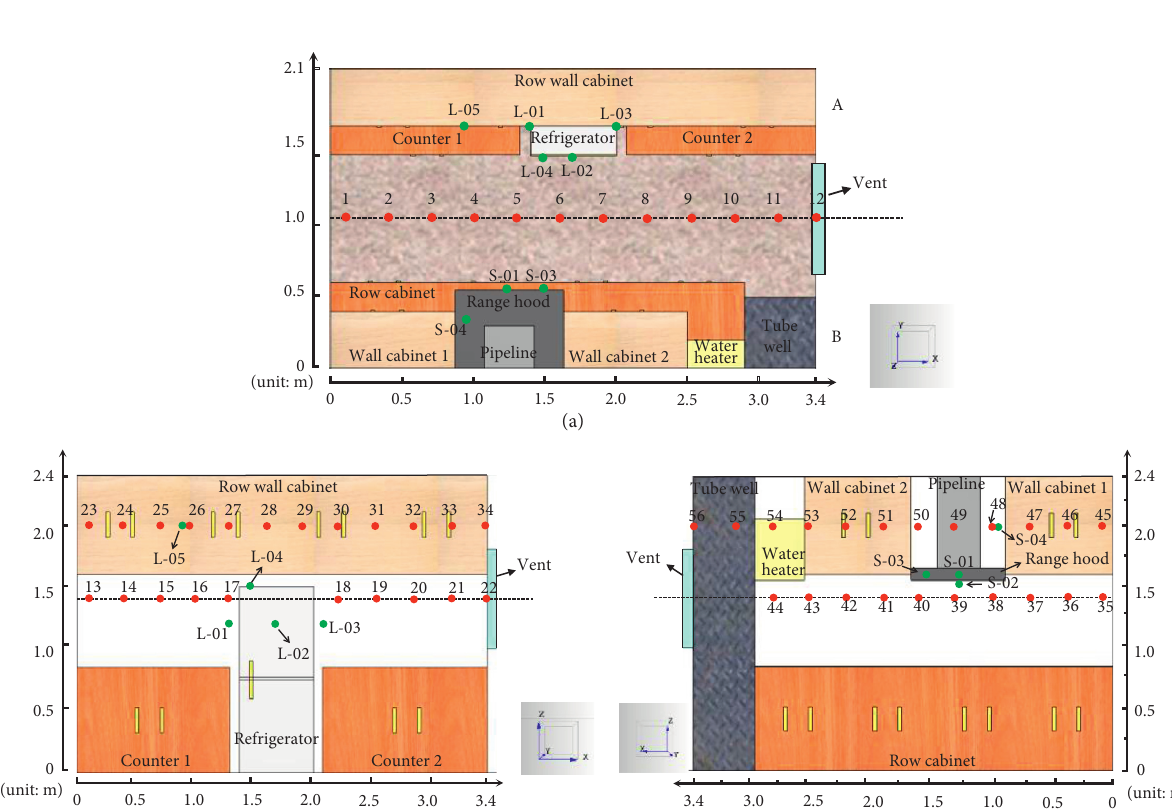
Figure 4: Specific layout of measuring points. (a) Physical model top view. (b) Part A. (c) Part